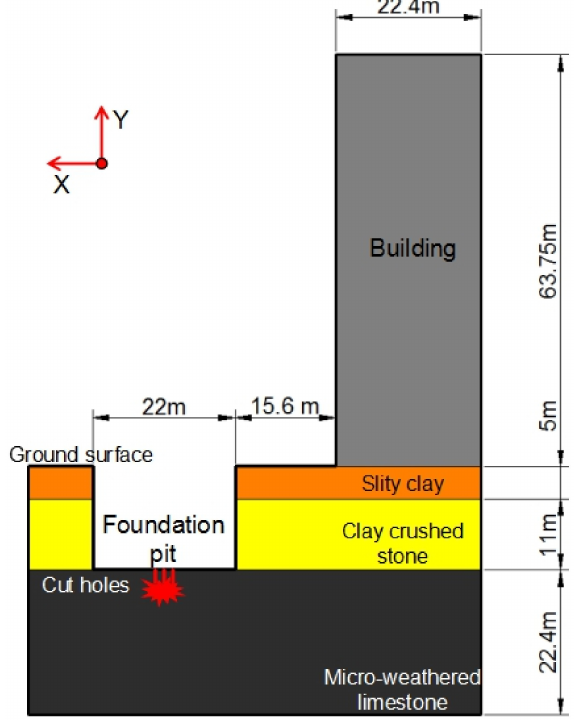
Figure 3. Profile of high-rise building and foundation pit relative